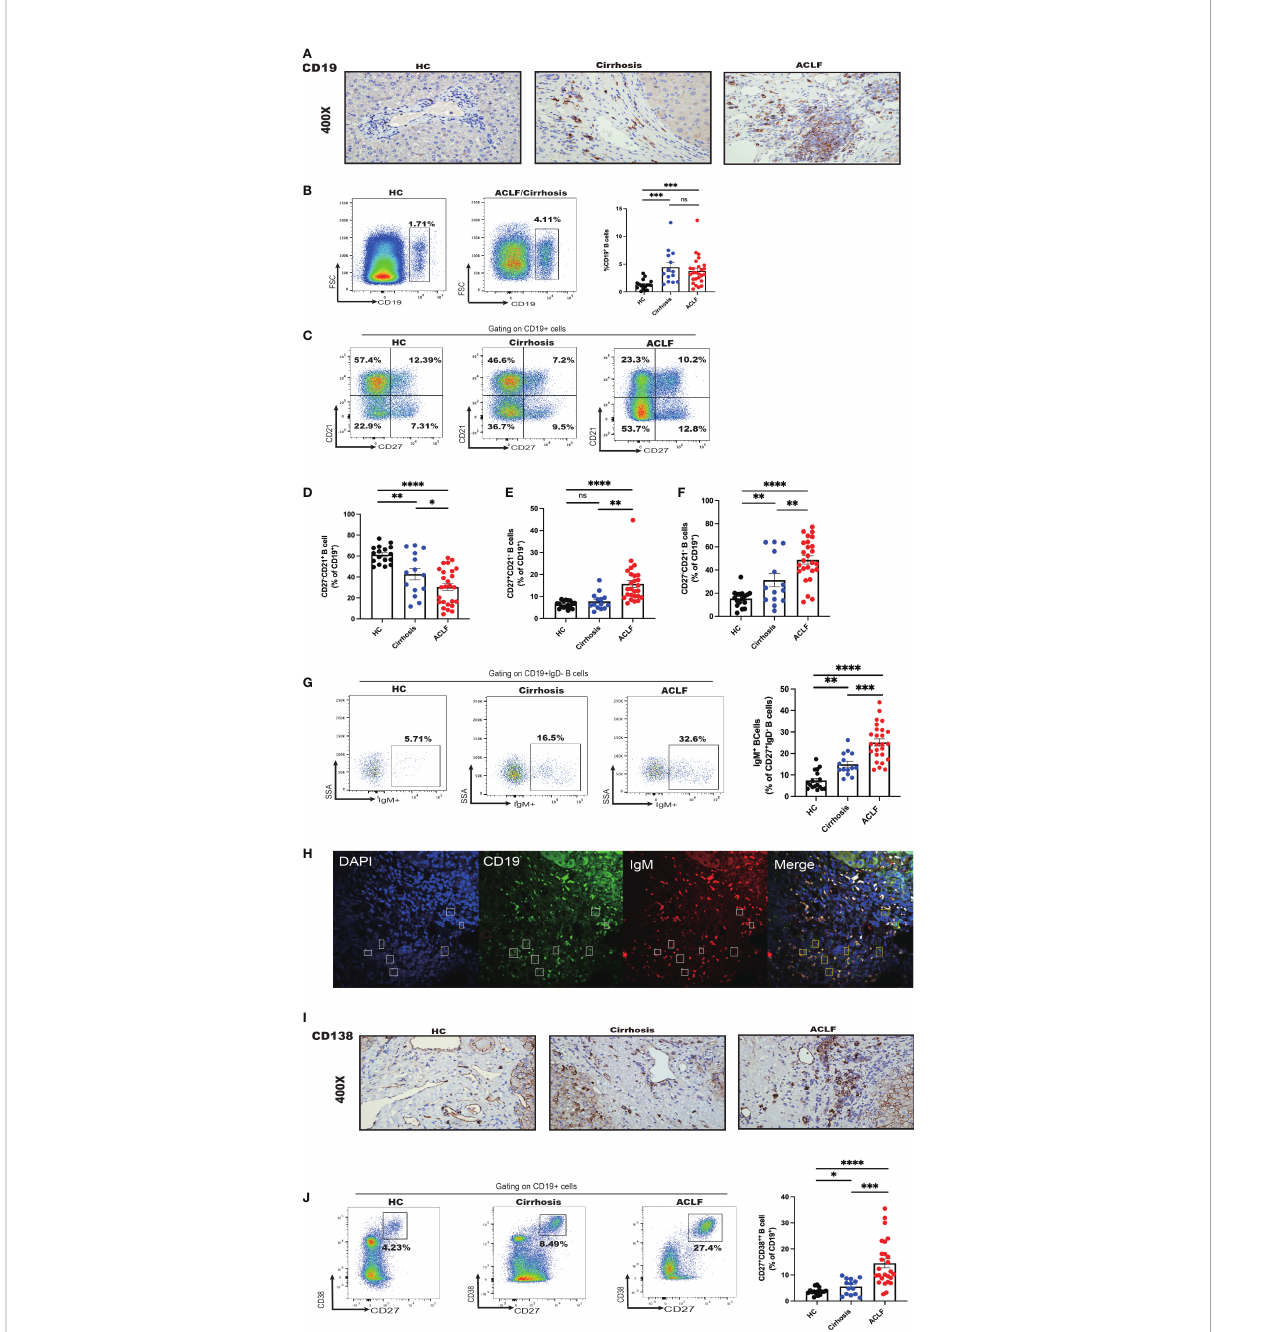
FIGURE 2 Intrahepatic B-cell delineation in ACLF, cirrhosis, and HC. (A) Representative immunohistochemistry images and quanti fi cation of CD19-positive cells in liver biopsies from ACLF, cirrhosis, and HC (HC, n = 5; cirrhosis, n = 10; ACLF, n = 10). (B) The frequency of CD19 + B cells in the liver from patients with ACLF compared with Cirrhosis and HC (HC, n = 17; cirrhosis, n = 14; ACLF, n = 26). (C – F) The frequency of CD27 − CD21 + CD19 + B cells, CD27 + CD21 − CD19 + B cells, and CD27 − CD21 − CD19 + B cells in the liver from patients with ACLF compared with cirrhosis and HC (HC, n = 17; cirrhosis, n = 14; ACLF, n = 26). (G) The frequency of CD27 + IgD − IgM + CD19 + B cells in the liver from patients with ACLF compared with cirrhosis and HC (HC, n = 17; cirrhosis, n = 14; ACLF, n = 26). (H) Representative confocal images of IgM + CD19 + cells using human liver biopsies from patients with ACLF. (I) Representative immunohistochemistry images and quanti fi cation of CD138-positive cells in liver biopsies from ACLF and cirrhosis (HC, n = 17; cirrhosis, n = 14; ACLF, n = 26). (J) The frequency of CD27 + CD38 ++ CD19 + B cells in the liver from patients with ACLF compared with Cirrhosis and HC (HC, n = 17; cirrhosis, n = 14; ACLF, n = 26). *p < 0.05, **p < 0.01, ***p < 0.001, and ****p < 0.0001; ns, not signi fi